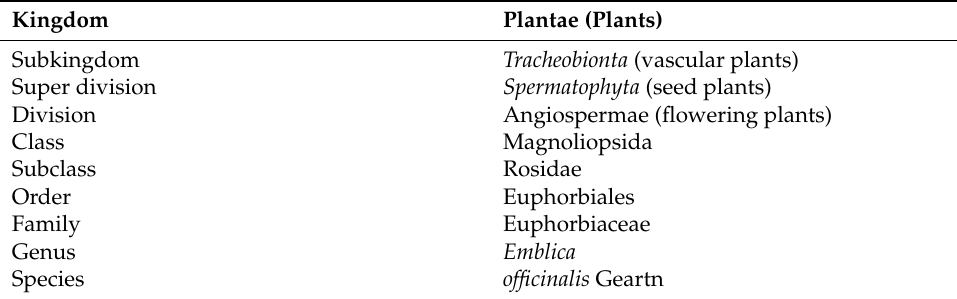
Table 2. Taxonomical classification of E. officinalis 1